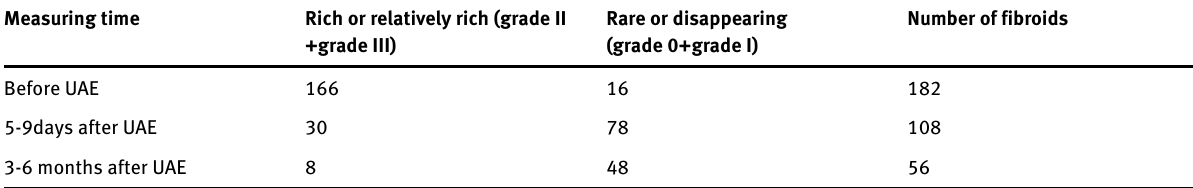
Figure 5. Status of fibroid 6 months after